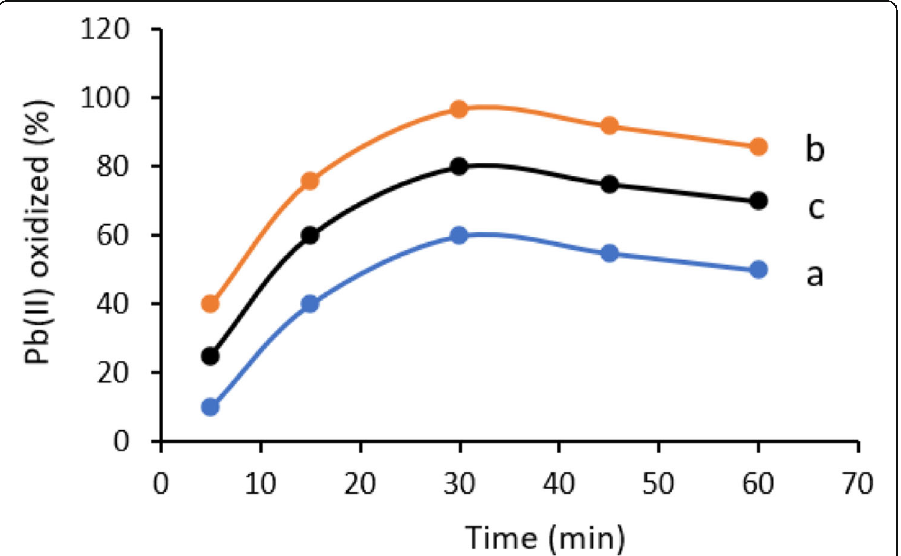
Fig. 6 The influence of the irradiation time on the photo-oxidation results at a pH 3, b pH 7, and c pH